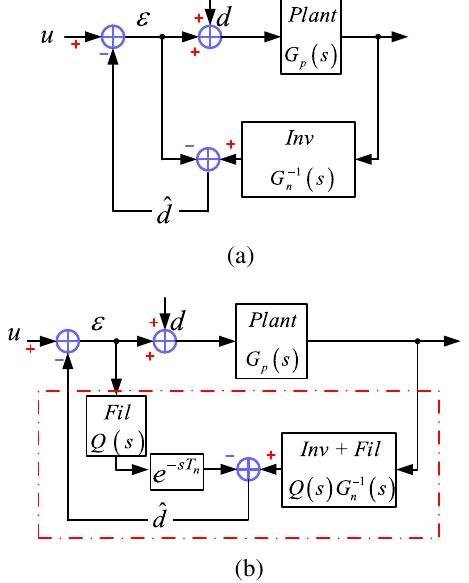
FIG. 3. Architecture of DOB control: (a) the basic structure of DOB control, (b) DOB control with Q filter and time-delay compensation